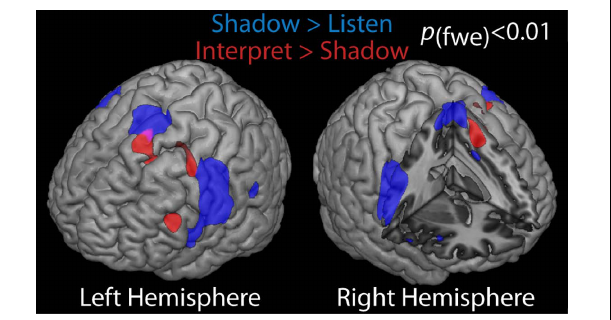
FIGURE 1 | Significant differences in activation levels in 34 non-experts, rendered on canonical single-subject brain. Contrasts shown are speech shadowing in L2 versus listening to L2 (blue) and simultaneous interpretation into L1 versus shadowing (red), at a family wise error corrected significance level of p < 0.01.